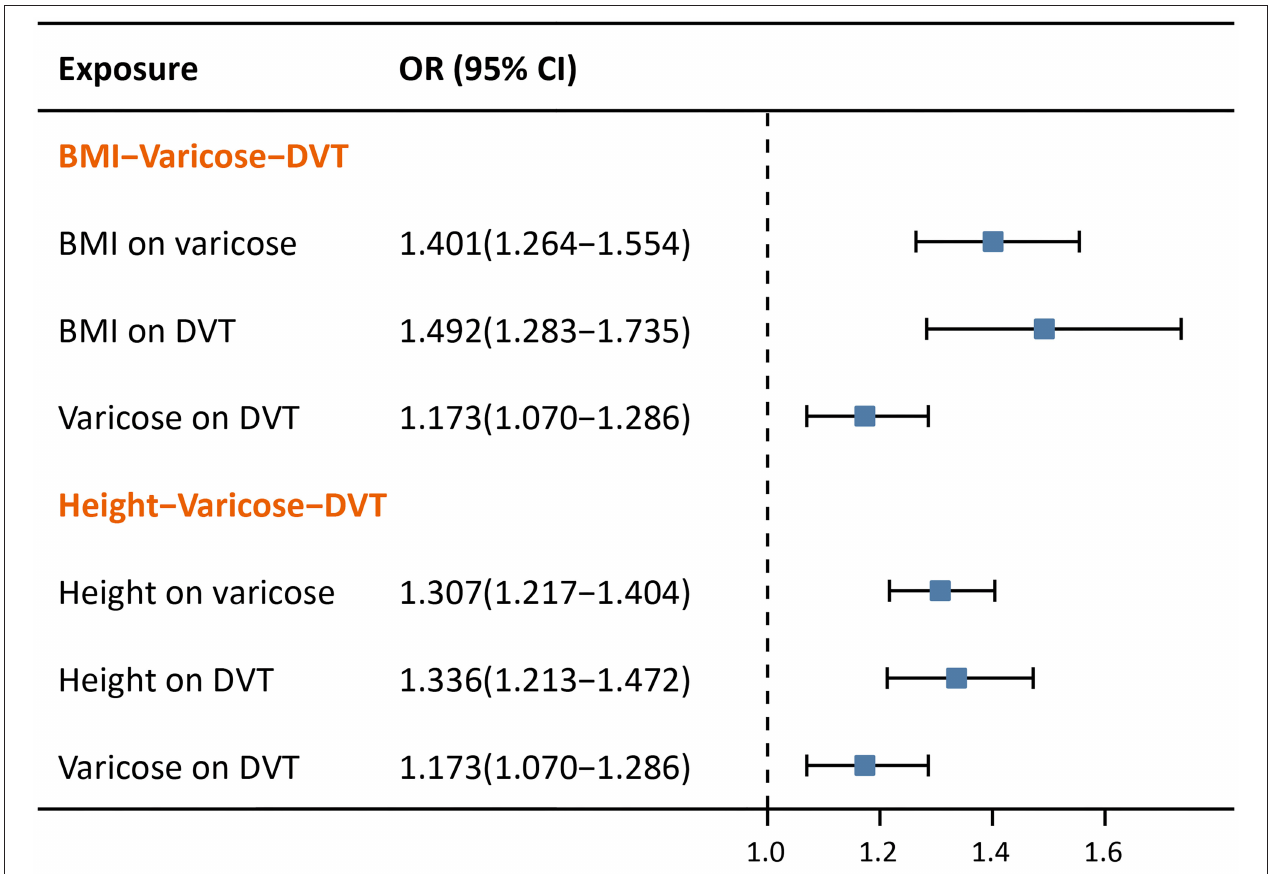
FIGURE 5 | Forest plots of two-step MR with BMI and